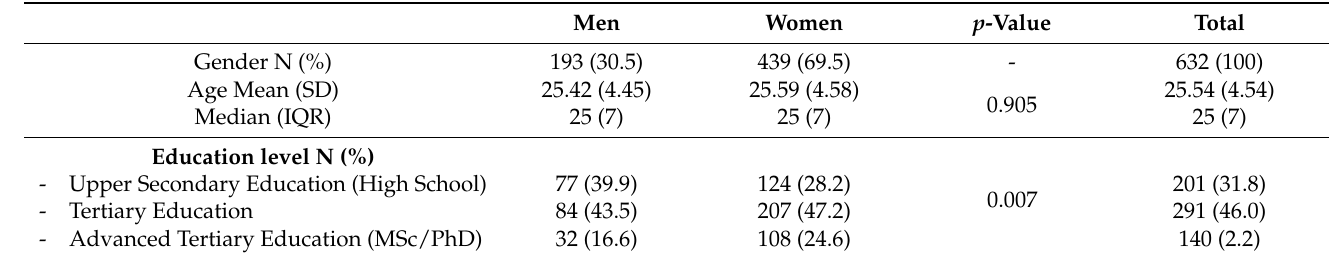
Table 1. Sociodemographic characteristics (N =